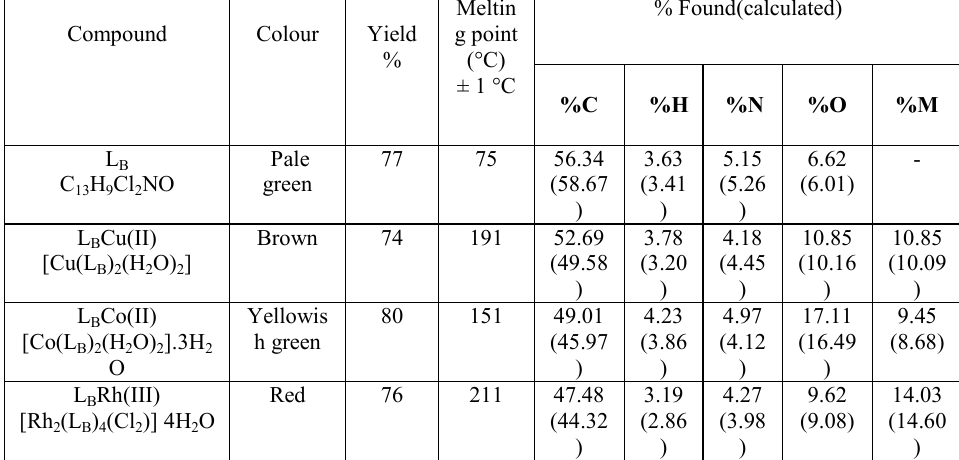
Table 1. Physical properties of the synthesized